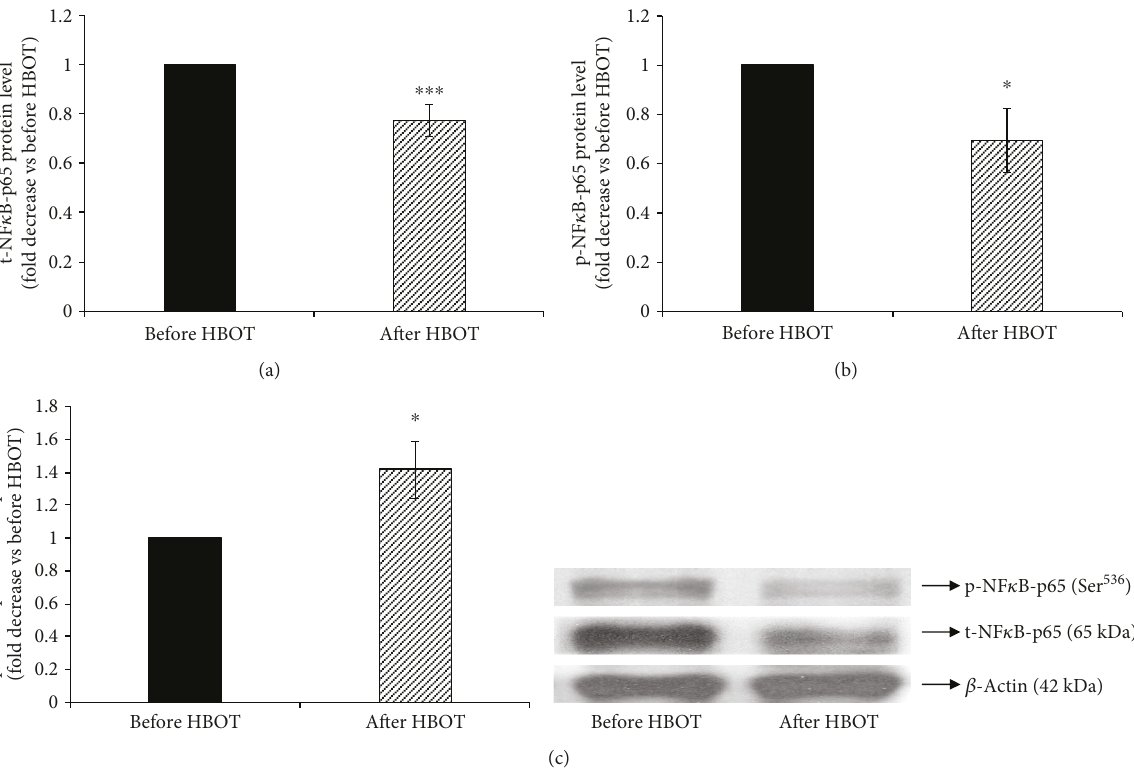
Figure 3: Phosphorylation of NF κ B-p65 at Ser 536 in lymphocytes after HBO exposure. (a) Level of t-NF κ B-p65 protein in lymphocytes, normalized to β -actin and expressed as fold change before HBOT (arbitrary control set at 1); (b) level of p-NF κ B-p65 (Ser 536 ) protein in lymphocytes, normalized to β -actin and expressed as fold change before HBOT (arbitrary control set at 1); (c) ratio of p-NF κ B-p65/t-NF κ B-p65 expressed as fold change before HBOT (arbitrary control set at 1). Inset: representative Western blots ( n = 5 – 15 ); ∗∗ p < 0 01 ; ∗ p < 0 05 ; p-NF κ B-p65: the phosphorylated form of p65 subunit of nuclear factor- κ B; t-NF κ B-p65: the total form p65 subunit of nuclear factor- κ B. Other abbreviations are under Table (Figure 4(a)) and total Akt protein level, normalized to β -actin (before HBOT =1-fold; after HBOT =0.89 ± 0.04-fold; p < 0 05 ) (Figure 5(a)). Similarly, HBOT decreased phosphorylation of ERK1/2 (Figures 4(b) and 4(c)) (before HBOT =1-fold; after HBOT = 0.79 ± 0.06-fold; p < 0 01 ) and phosphorylation of Akt (Figures 5(b) and 5(c)) (before HBOT =1-fold; after HBOT =0.57 ± 0.11-fold; p < 0 01 ).